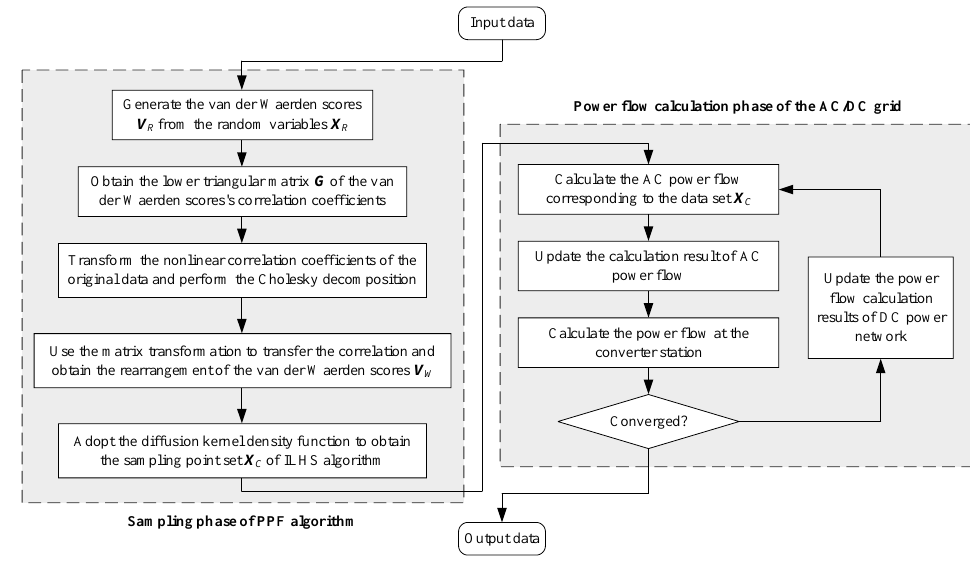
Figure 2. Flow chart of improved PPF